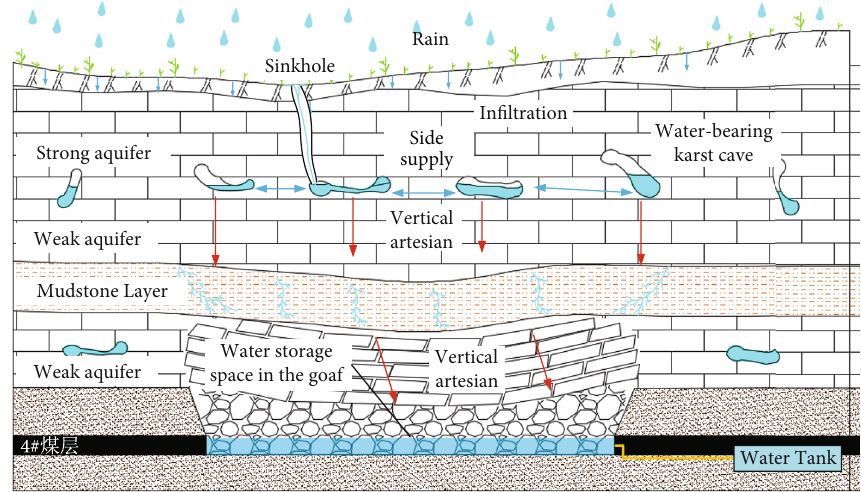
Figure 8: Conceptual model of water inrush from karst roof in coal